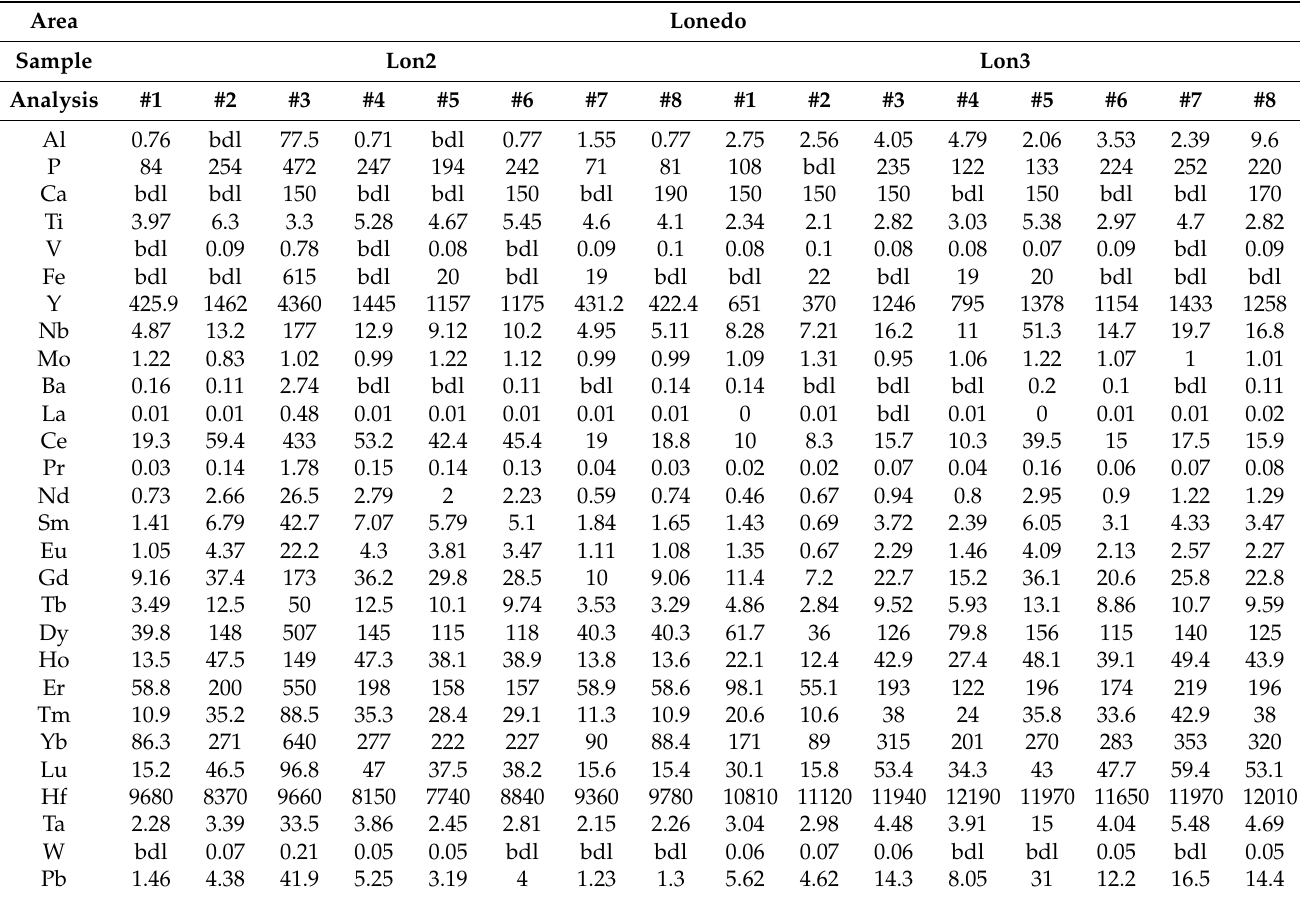
Table 4. LA-ICP-MS zircon analyses ( µ g/g) from Lonedo.